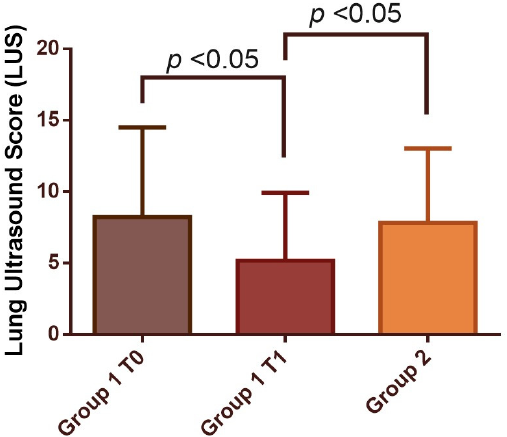
Figure 2. LUS score at the time of administration of mAb (T0) and at the 3-month visit (T1) compared to the LUS score found in the 3-month visit in patients who did not experience the mAb treatment.